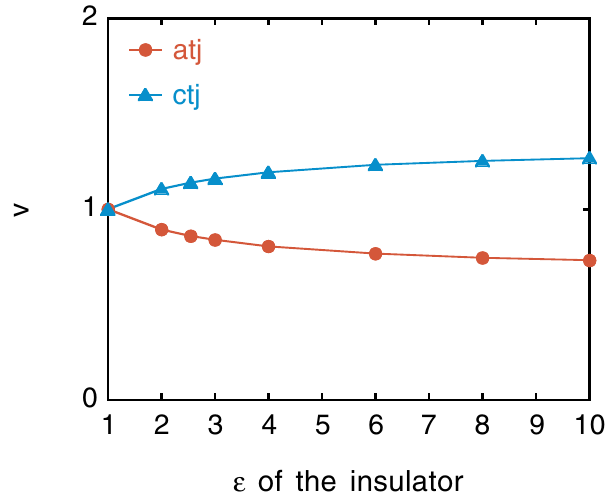
FIG. 4. (Color) The quantity v as a function of " for the idealized 45 (cid:1) vacuum-insulator system outlined in Figs. 1 and 2. The absolute value of the electric-field magnitude E either an anode or cathode triple junction (atj or ctj) is propor- tional to r v (cid:10) 1 , where r is the distance from the junction